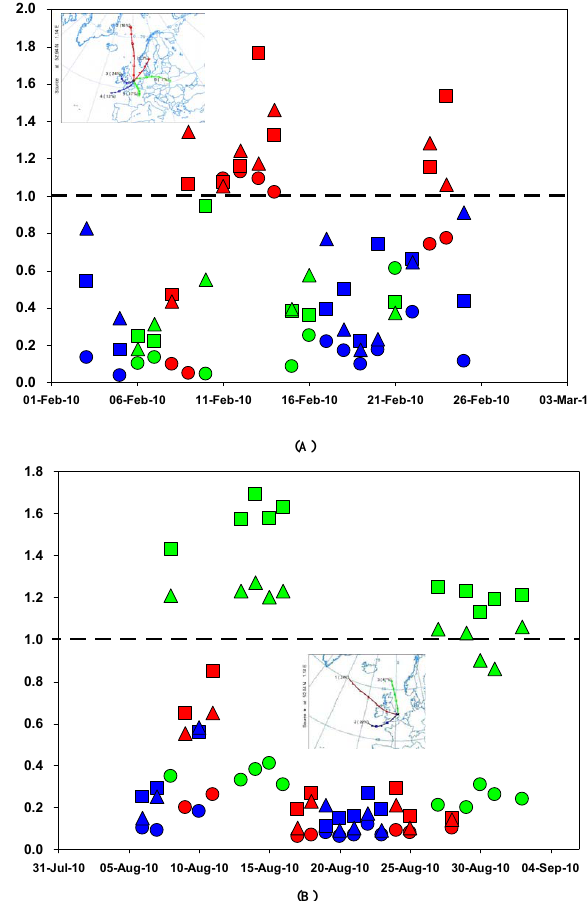
Fig 2. Quinone to parent-PAH ratios (sum of vapour and particulate phases) during (A) winter and (B) summer. Circles – PQ / PHE; squares – AQ / ANT and triangles – B(a)A-7,12 / B(a)A. Colours signify three different air masses determined by cluster analysis, see embedded image and/or Fig. S1a and S1b for colour codes